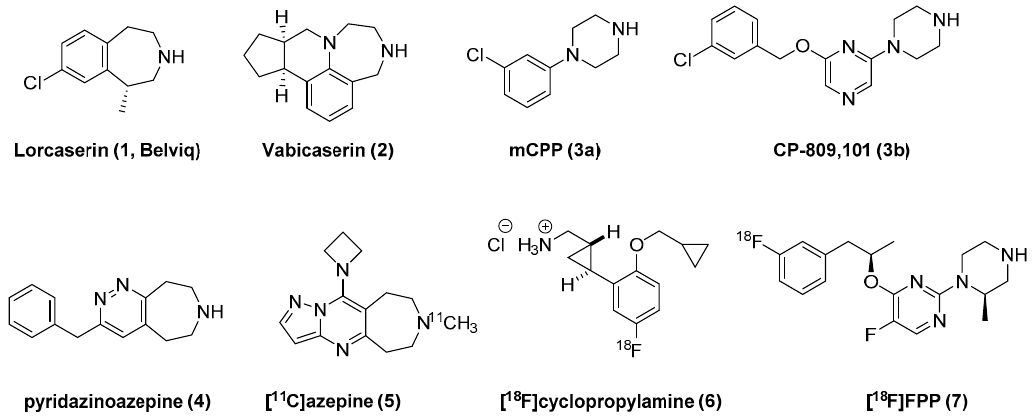
Figure 1. The representative 5-HT 2C selective agonists and PET radioligands.